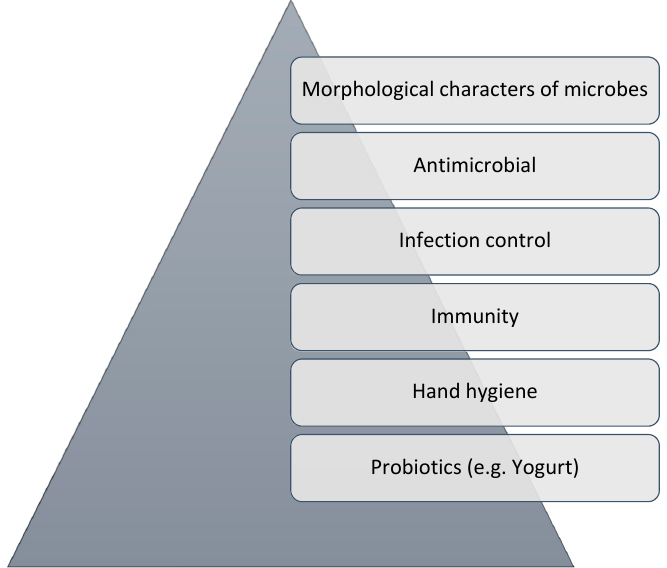
Figure 2. Topics covered during educational intervention.